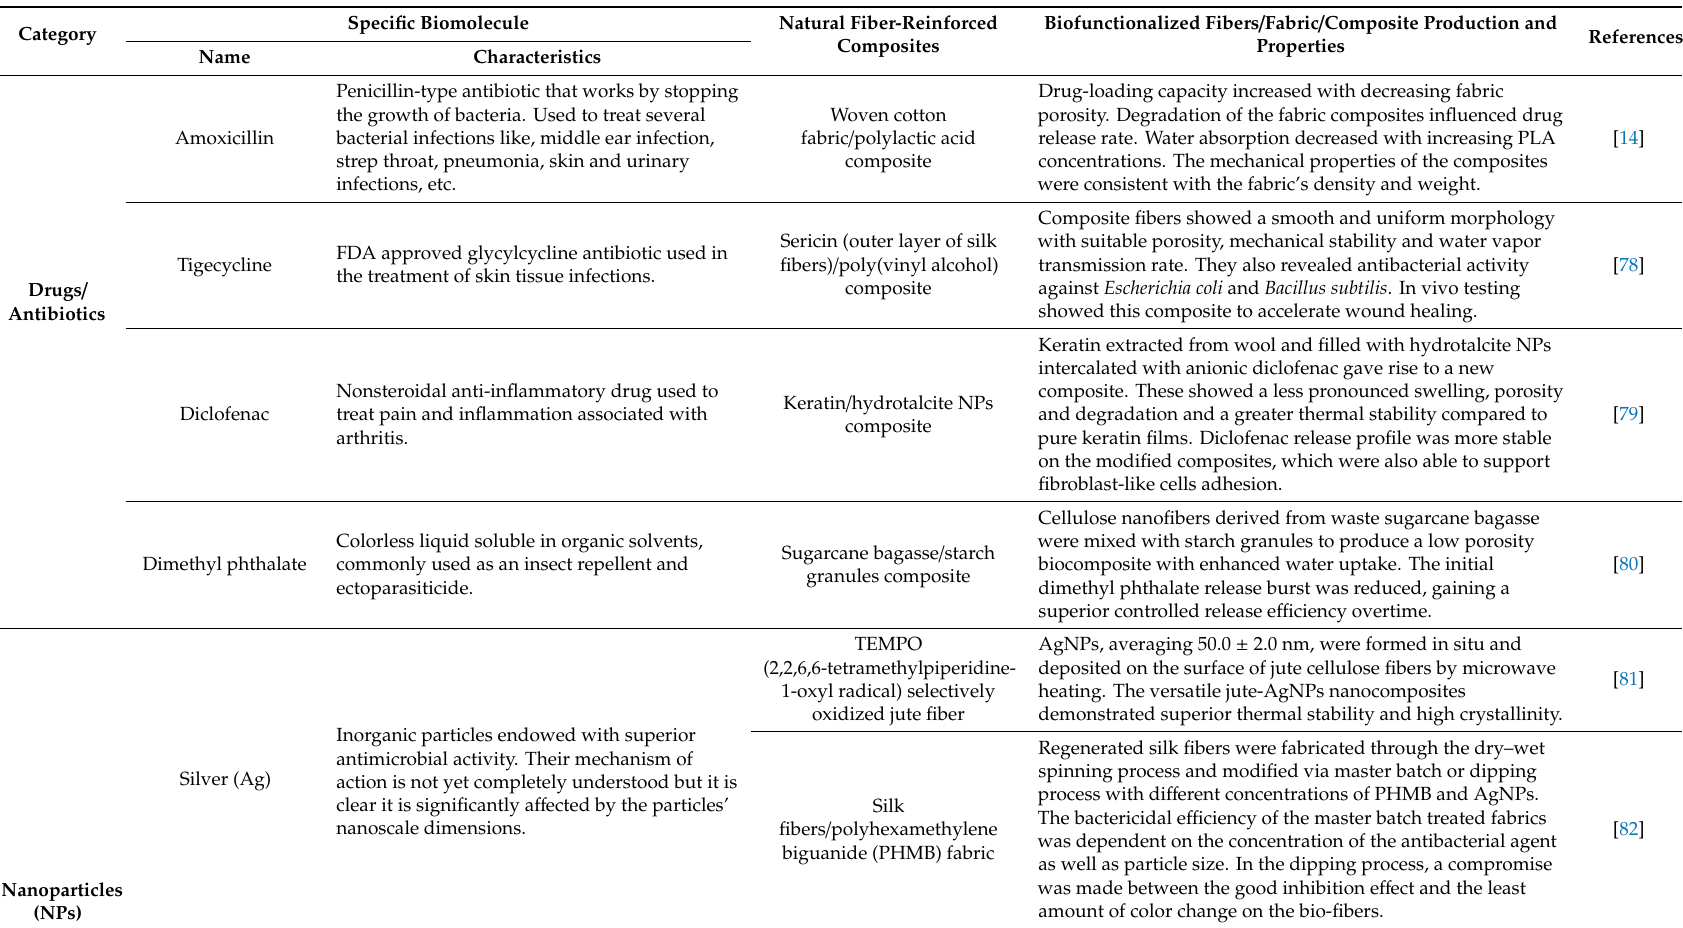
Table 4. Application of biomolecules in the production of natural fiber-based composites for potential biomedical applications and respective properties. Most of the selected combinations have already been established for biomedical uses. However, there are a few that, even though the publications do not state those as potential applications, the authors feel that the combinations or the principles described may be of interest for biomedical uses and as such were included. This table compiles examples of natural fiber-reinforced composites modified with multiple biomolecules reported in the last 10